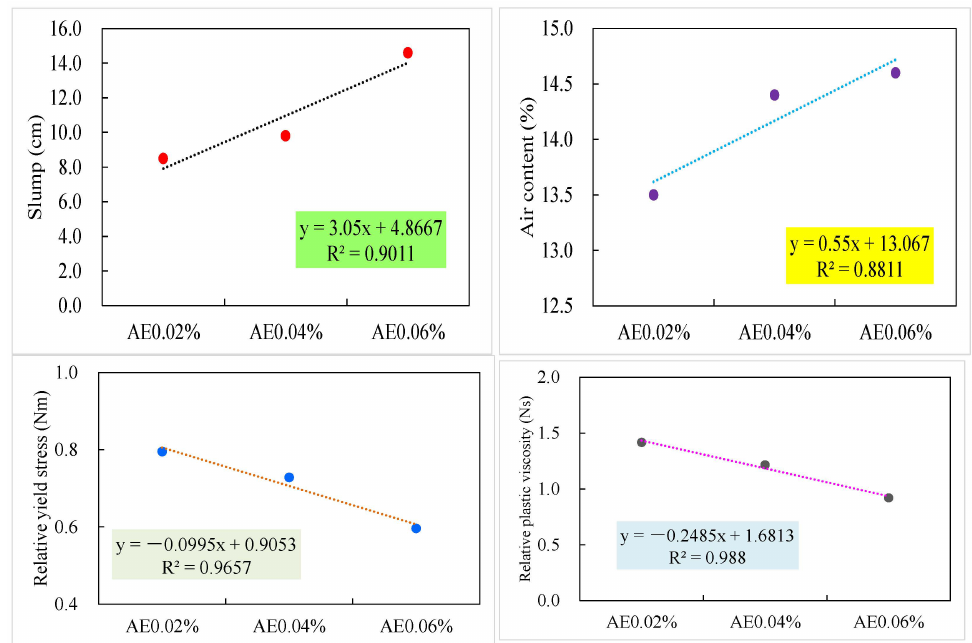
Figure 10. Effect of air-entraining agent on slump, air content, relative yield stress, and